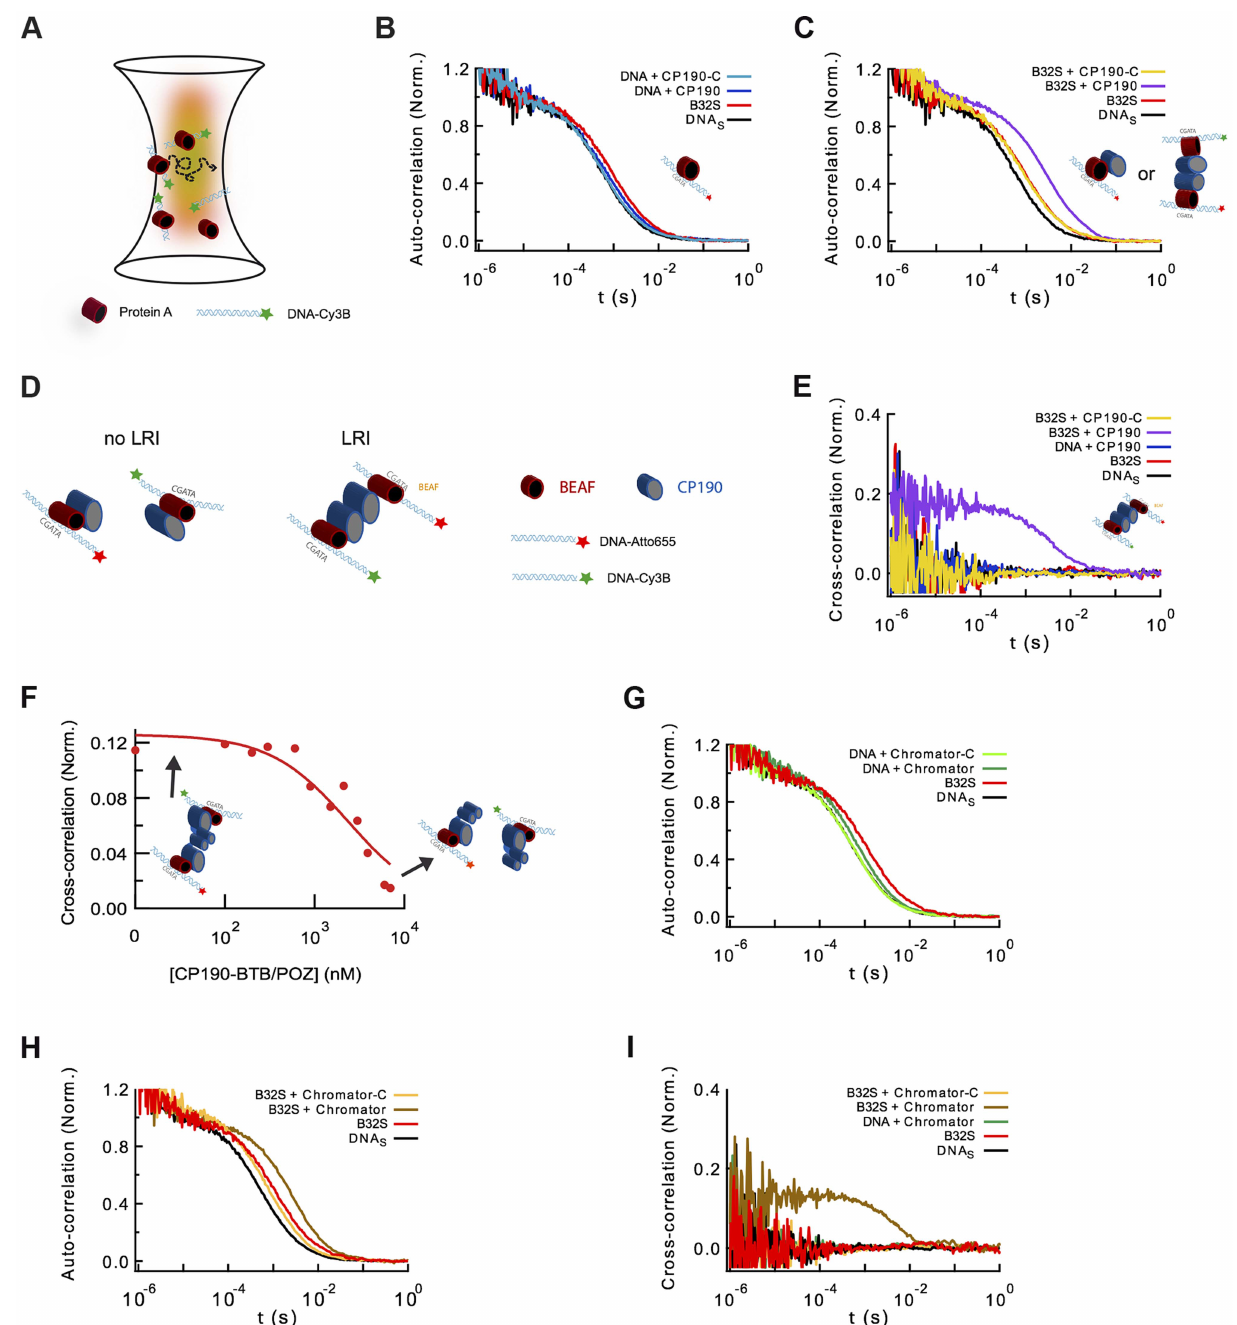
Figure 5. Formation of long-range interactions by insulator proteins. (A) Scheme depicting a typical fluorescence fluctuation spectroscopy configuration. Fluorescently-labeled dsDNA fragments (cyan ribbon with green star) diffuse in and out of an excitation volume (red gradient) producing a time-dependent fluctuation in the fluorescence signal. Binding of protein (red cylinder) to DNA lead to a larger molecular complex, with a corresponding increase in its diffusion time. (B) Normalized auto-correlation of DNA S -Cy3B (2.5 nM, black), and shift in the auto-correlation curve due to BEAF32 binding (400 nM, B32S complex, red) or CP190 binding (50 nM, blue). No noticeable change in the diffusion time is observed when adding CP190-C (50 nM, light blue) to DNA S -Cy3B. (C) Normalized auto-correlation of DNA S -Cy3B (black), B32S (red), and a complex of B32S with CP190 (violet) or CP190-C (yellow). Addition of CP190 (50 nM) to B32S (400 nM) considerably increased the diffusion time, consistent with direct BEAF32/CP190 interactions leading to the formation of a higher molecular mass complex. Inset shows the two possible models that could lead to this increase in diffusion time. (D) Scheme presenting the two models tested by fluorescence cross-correlation spectroscopy. The formation of long-range interactions between B32S complexes (with either a Cy3B- or an atto655-labeled DNA S fragment) lead to a cross-correlation signal between these two colors. In contrast, the absence of cross-correlation signal implies no long-range interaction between B32S complexes. BEAF is shown in red, and CP190 in blue. DNA S is represented by a cyan ribbon with a star representing the fluorophore at its 5 9 -end. (E) Cross-correlation between the two fluorophores was only observed in the presence of CP190 (50 nM) and B32S (400 nM), and not when DNA alone, CP190 + DNA S , or CP190-C + B32S were used at the same concentrations. (F) CP190 (50 nM) was pre-incubated with B32S (400 nM BEAF32), leading to a complex with a large cross-